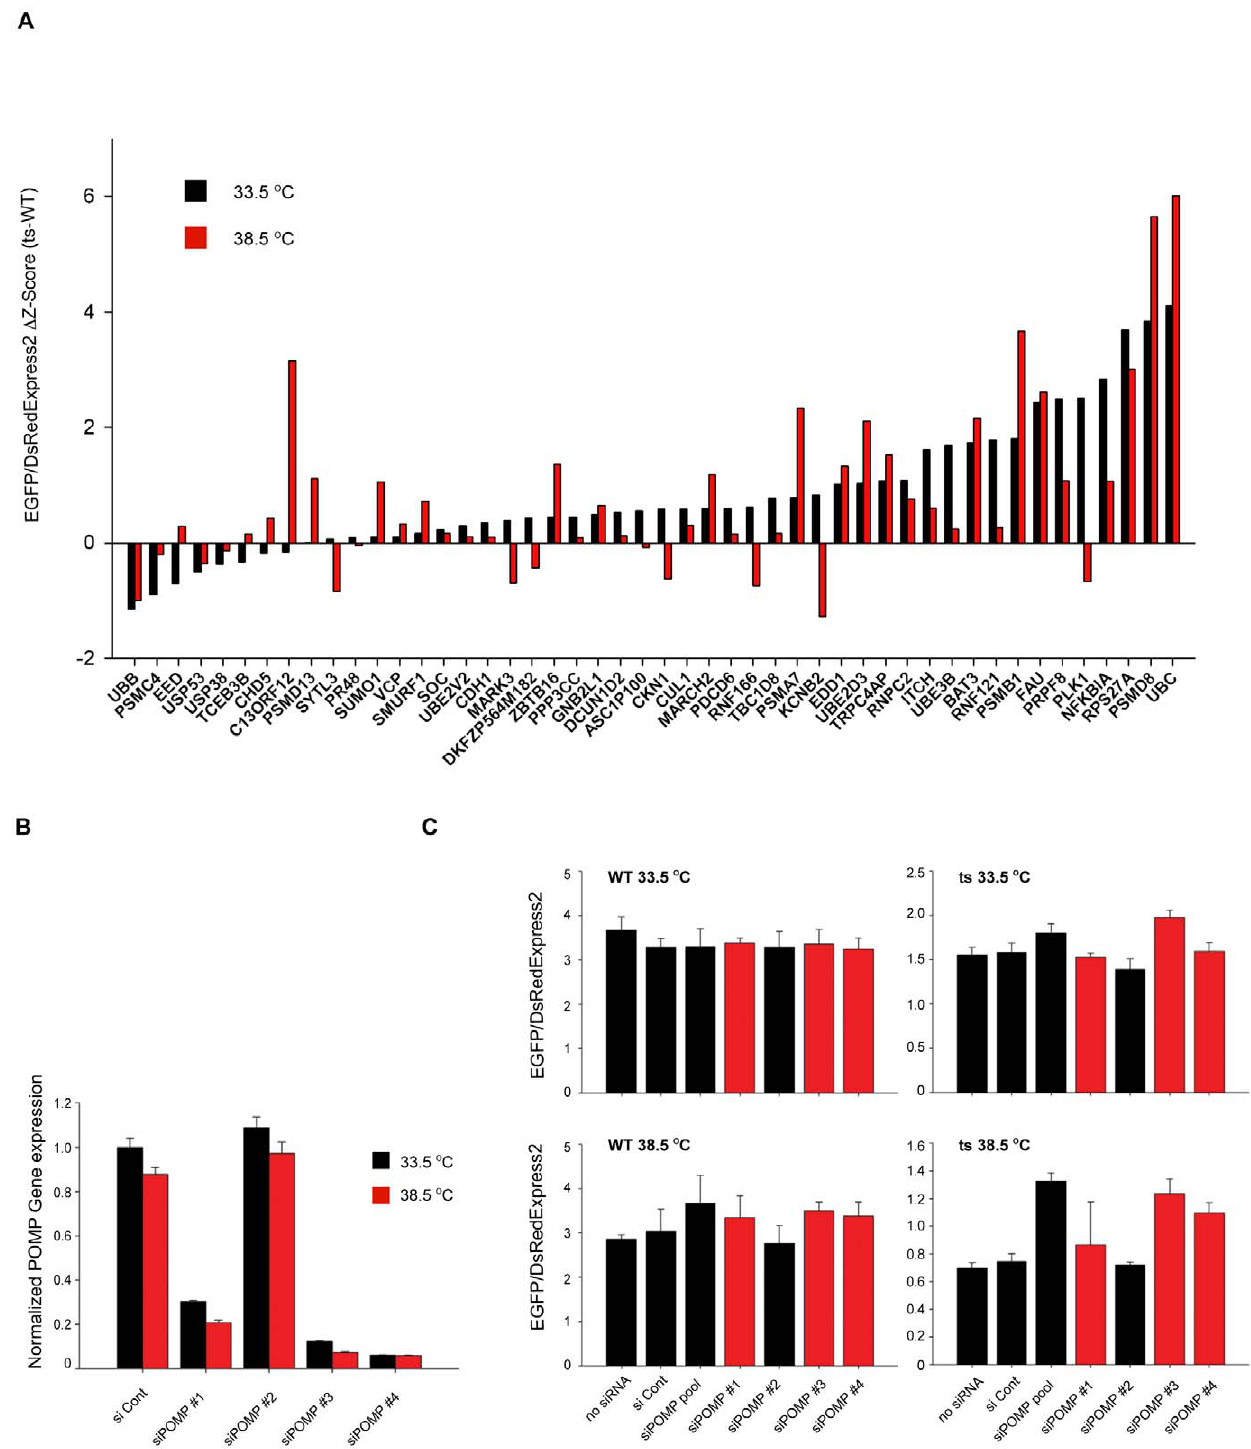
Figure 4. PQC Validation of primary hits. a) U2OS cells expressing either LTag(WT)-EGFP or LTag(ts)-EGFP and NLS-DsRedExpress2 were screened in quadruplicate at 33.5 u C or 38.5 u C using the validation library described in Figure 3C. The D Z-score is calculated as the difference between the EGFP/DsRedExpress2 ratio Z-score obtained using LTag(ts)-EGFP cells and the EGFP/DsRedExpress2 ratio Z-score for LTag(WT)-EGFP expressing cells. C13ORF12 is also known as POMP . b) Deconvolution and measurement by quantitative RT-PCR of the RNA silencing activity of the original siGenome pool of 4 siRNA oligos targeting the POMP gene. c) Measurement of the biological activity of the 4 siRNA oligos directed against the POMP gene in the PQC activity assay. Red bars represent siRNA oligos possessing siRNA silencing activity (see b)). Values represent averages + / 2 S.E.M of 4 experiments.